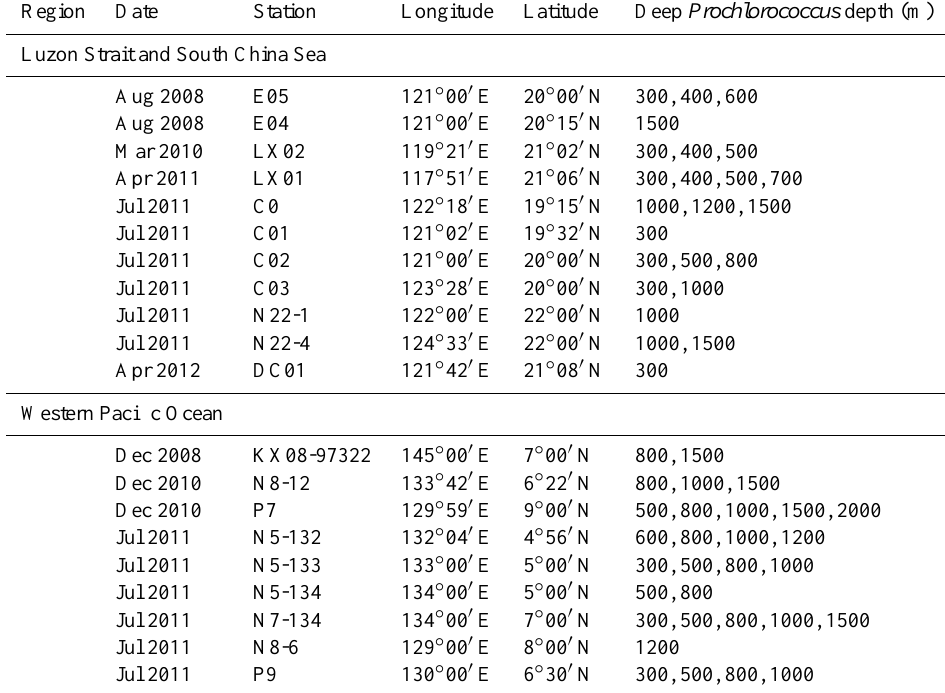
Table 1. Locations and water depths where deep Prochlorococcus were observed in the western Pacific Ocean, northern South China Sea, and Luzon Strait. Region Date Station Longitude Latitude Deep Prochlorococcus depth (m) Luzon Strait and South China